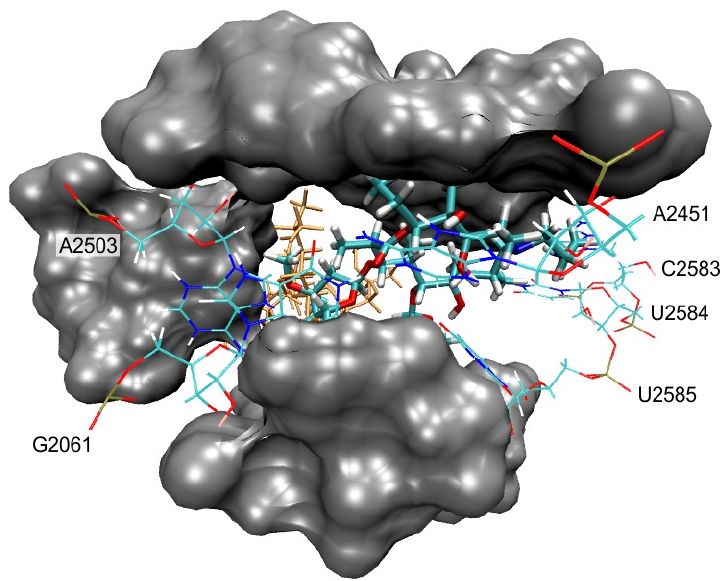
Figure 7. E. coli ribosome-binding mode of 1a that corresponds to the AZI-1 primary binding site [5]. Erythromycin found in the crystal structure (PDB code: 4V7U) is shown as sticks and colored orange. Nucleotides with which compound 1a forms H-bonds are shown as wires and labeled. Binding site residues forming van der Waals interactions with 1a (A2058, A2059, A2503, U2504, G2505, U2506, A2062, C2063, C2452, U2584, U2585 and U2586) are shown as grey surfaces.